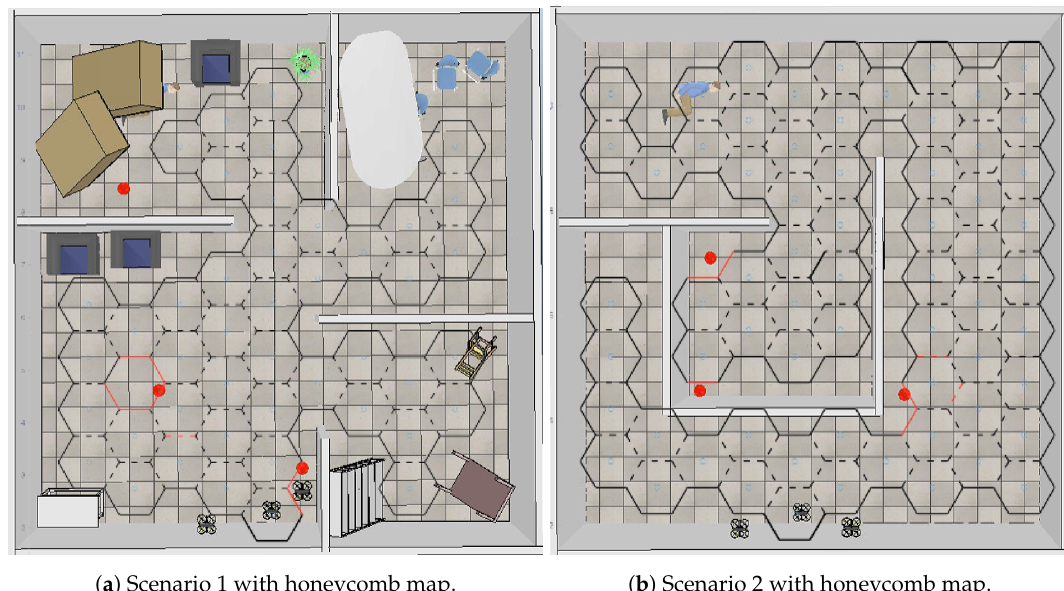
Figure 10. Scenarios merged with honeycomb map.